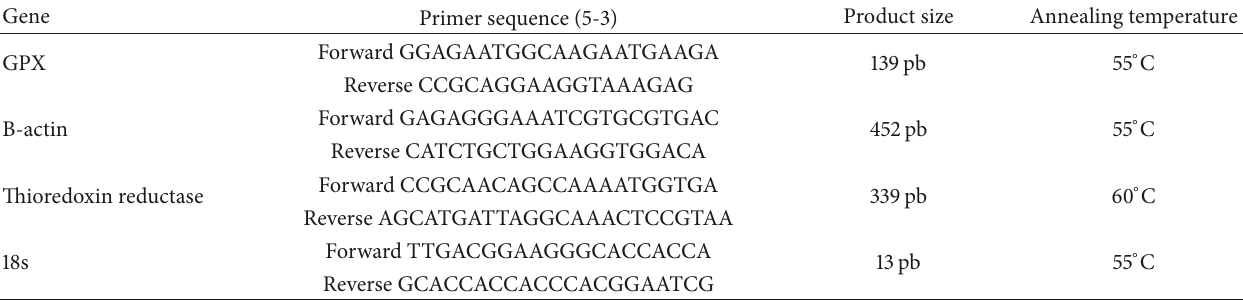
Table 1: Details giving primer sequences, expected product sizes, and annealing temperature for the genes